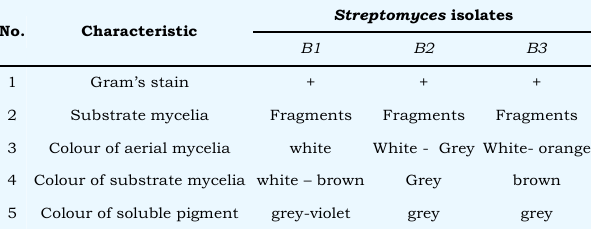
Table 3 Cultural and morphology characteristics of Streptomyces isolates after 7 days growth on ISP 2